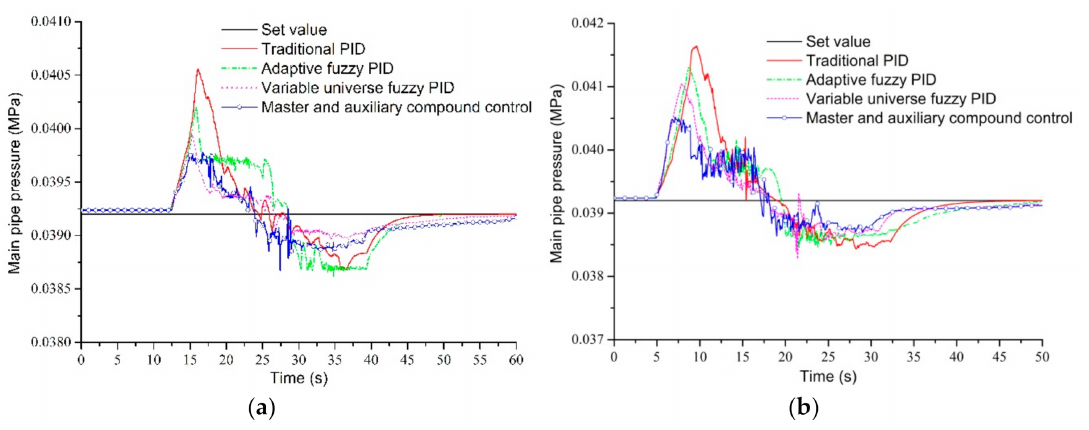
Figure 15. Anti-interference performance curve: ( a ) Delay time 4 s; ( b ) Delay time 10